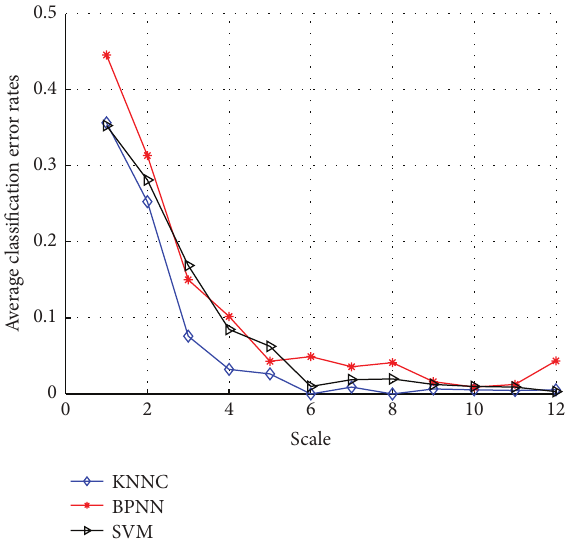
Figure 7: Diagram of average classification error rate versus